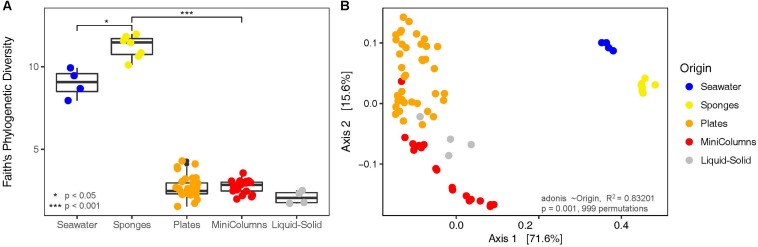
Diversity analyses of the bacterial communities derived from environmental samples and the different cultivation approaches. (A) Faith’s Phylogenetic Diversity and (B) Principal Coordinates Analysis on weighted UniFrac distances.